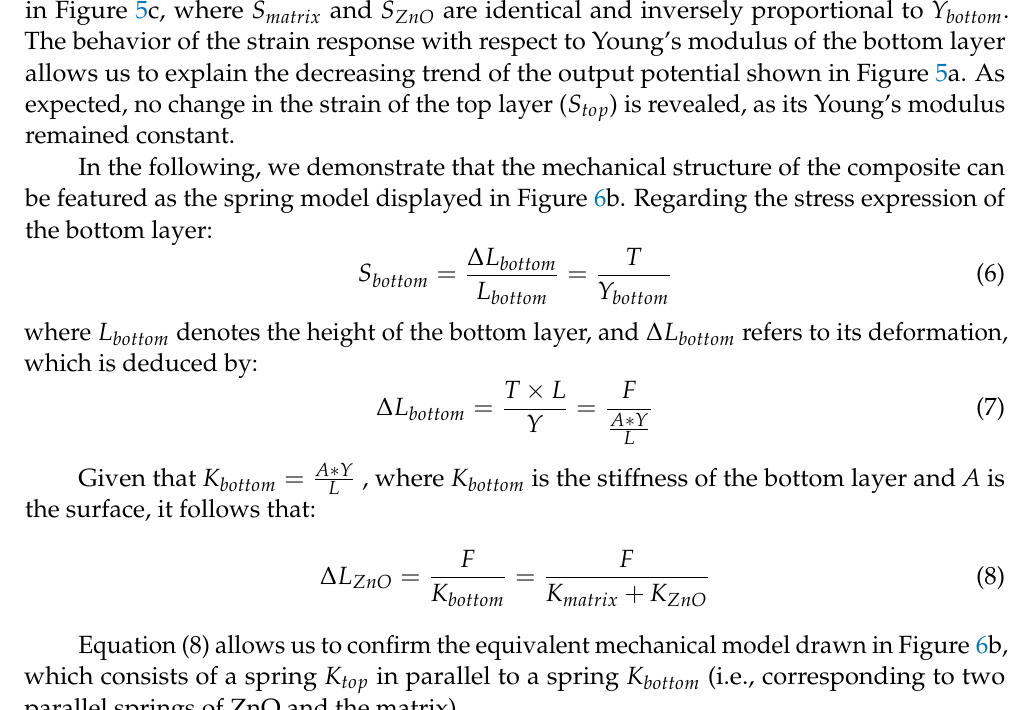
Figure 6. Equivalent mechanical schemes: ( a ) ideal fiber composite material; and ( b ) equivalent spring model.